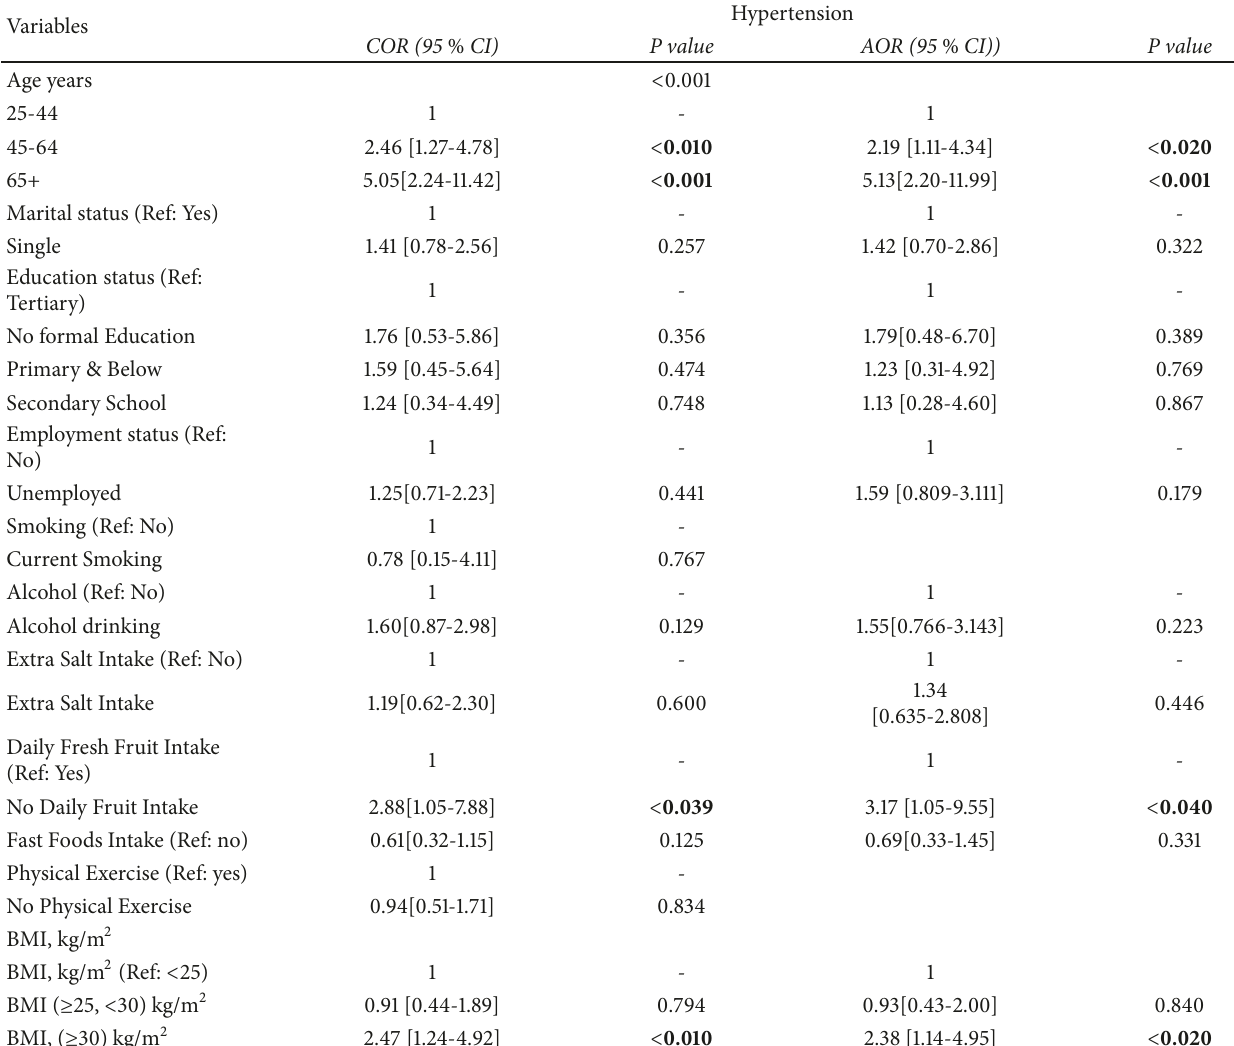
Table 4: Binary and multivariable logistic regression analysis between predictor variables and hypertension among people living in Kpone- Katamanso District, Accra,